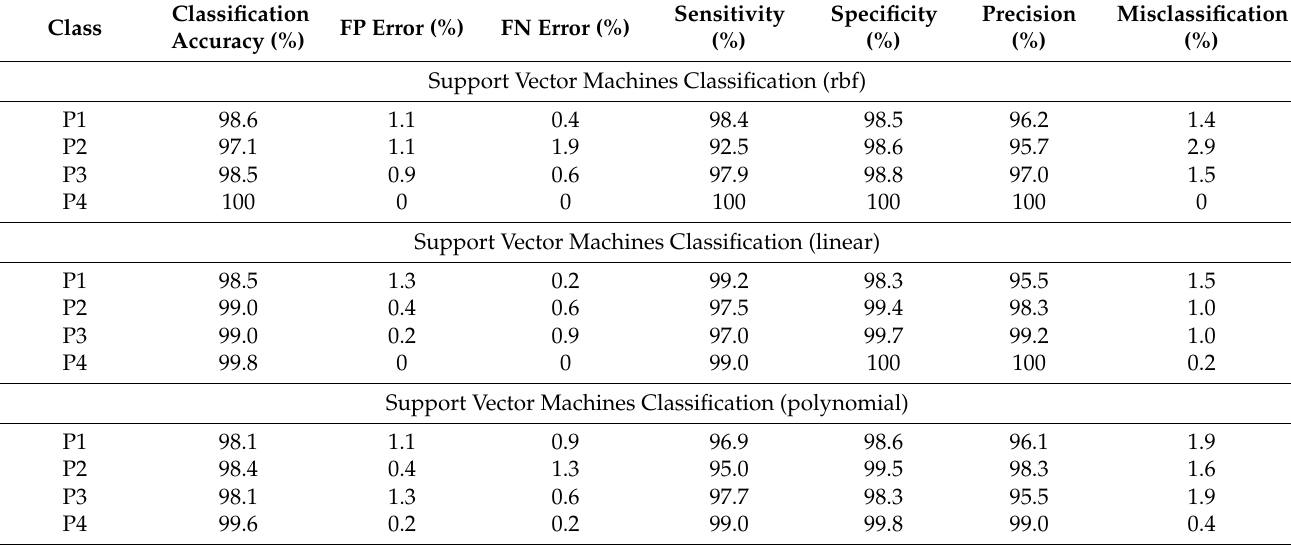
Table 8. The overall mean performance measures of the combined SNV and SNV+DT corrected data for the SVM-C models used to assess the validation results for the classification of patties into four